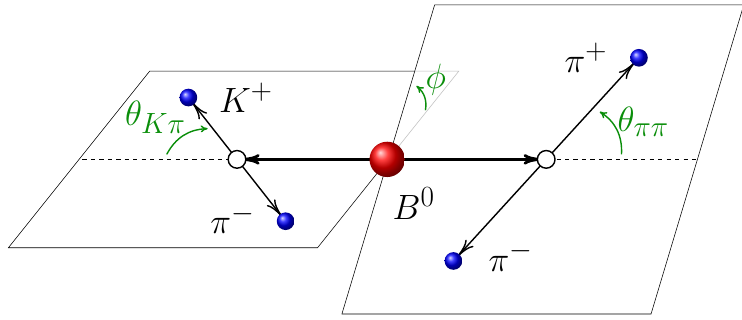
Figure 3. De(cid:12)nition of the helicity angles in the B 0